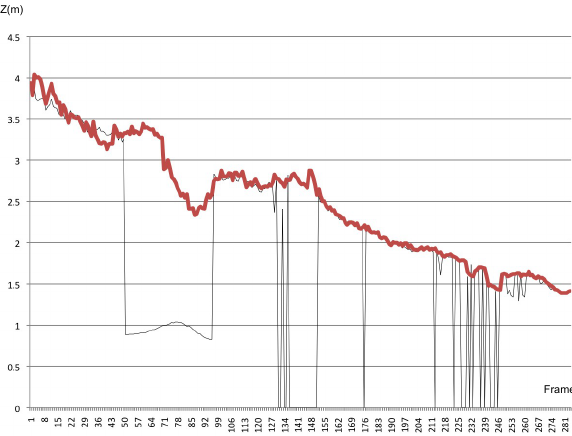
Figure 32. Descent of the Autonomous Underwater Vehicle (AUV) MARES towards the target: estimation algorithm with and without a filter. The black curve is the estimation without filter and the red curve is the estimation with filter.